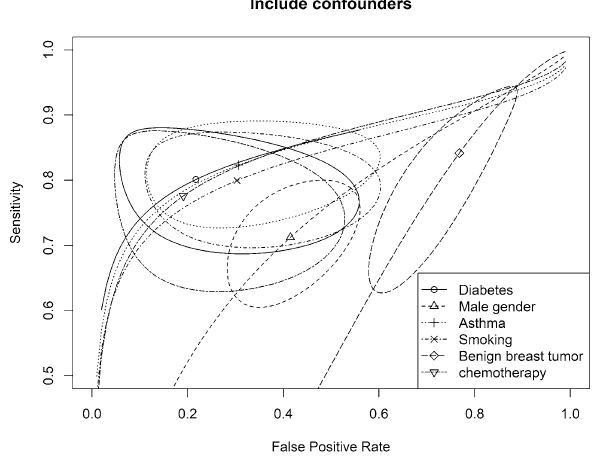
Figure 3. Summary receiver operating characteristic (SROC) cures for diagnostic accuracy that includes confounding factors or comorbidities. Legends: This figure shows a joint estimate of false positive rate and sensitivity for the electronic nose data with 95% confidence and prediction regions. Scatter points are the accuracy obtained from different machine learning models, and the solid closed curve is the 95% confidence region.